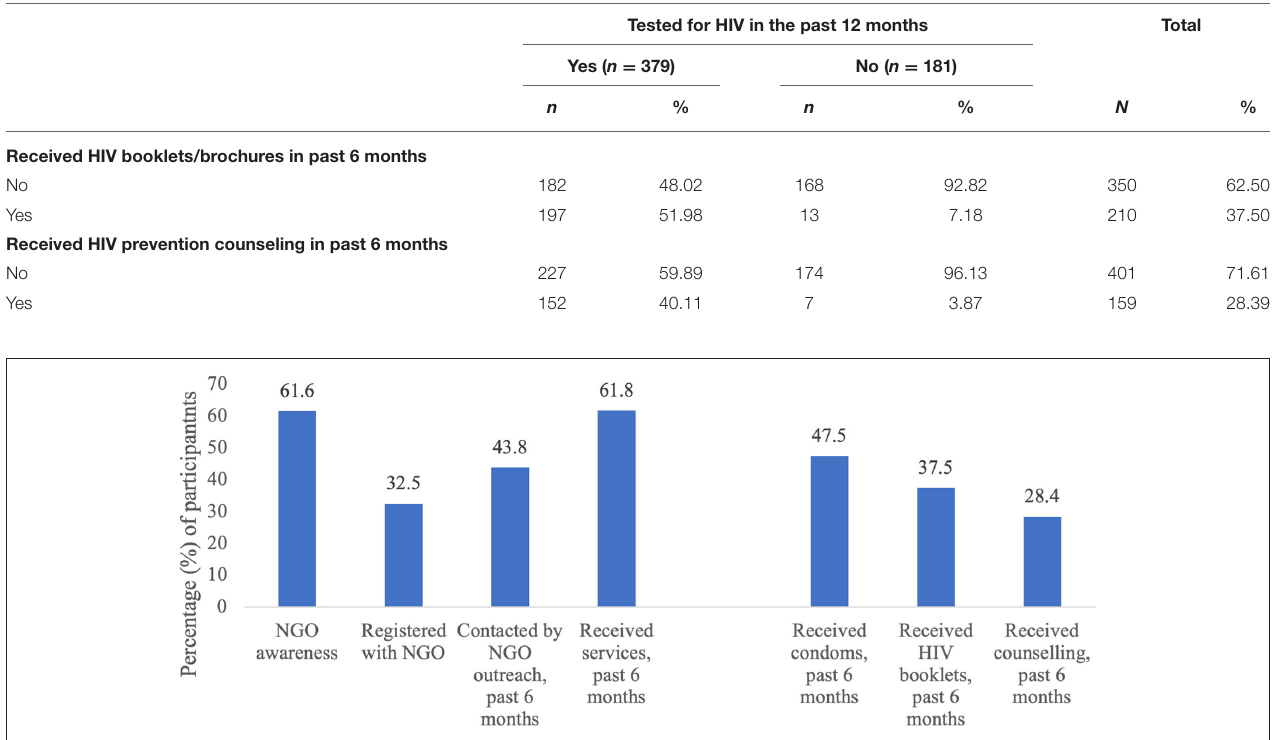
FIGURE 1 | Reported awareness of non-governmental organizations offering HIV prevention services and service use among sex worker participants ( N =